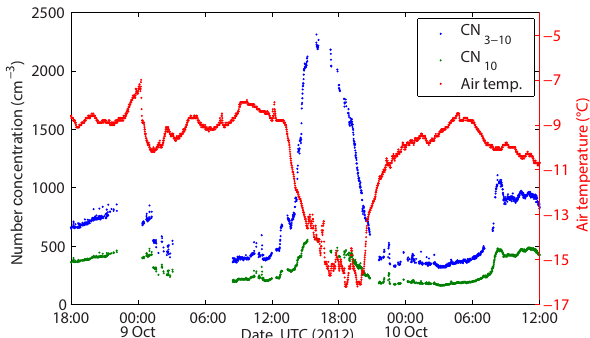
Figure A8. Air temperature and aerosol number concentrations in the two size ranges during the enhanced aerosol event of 9